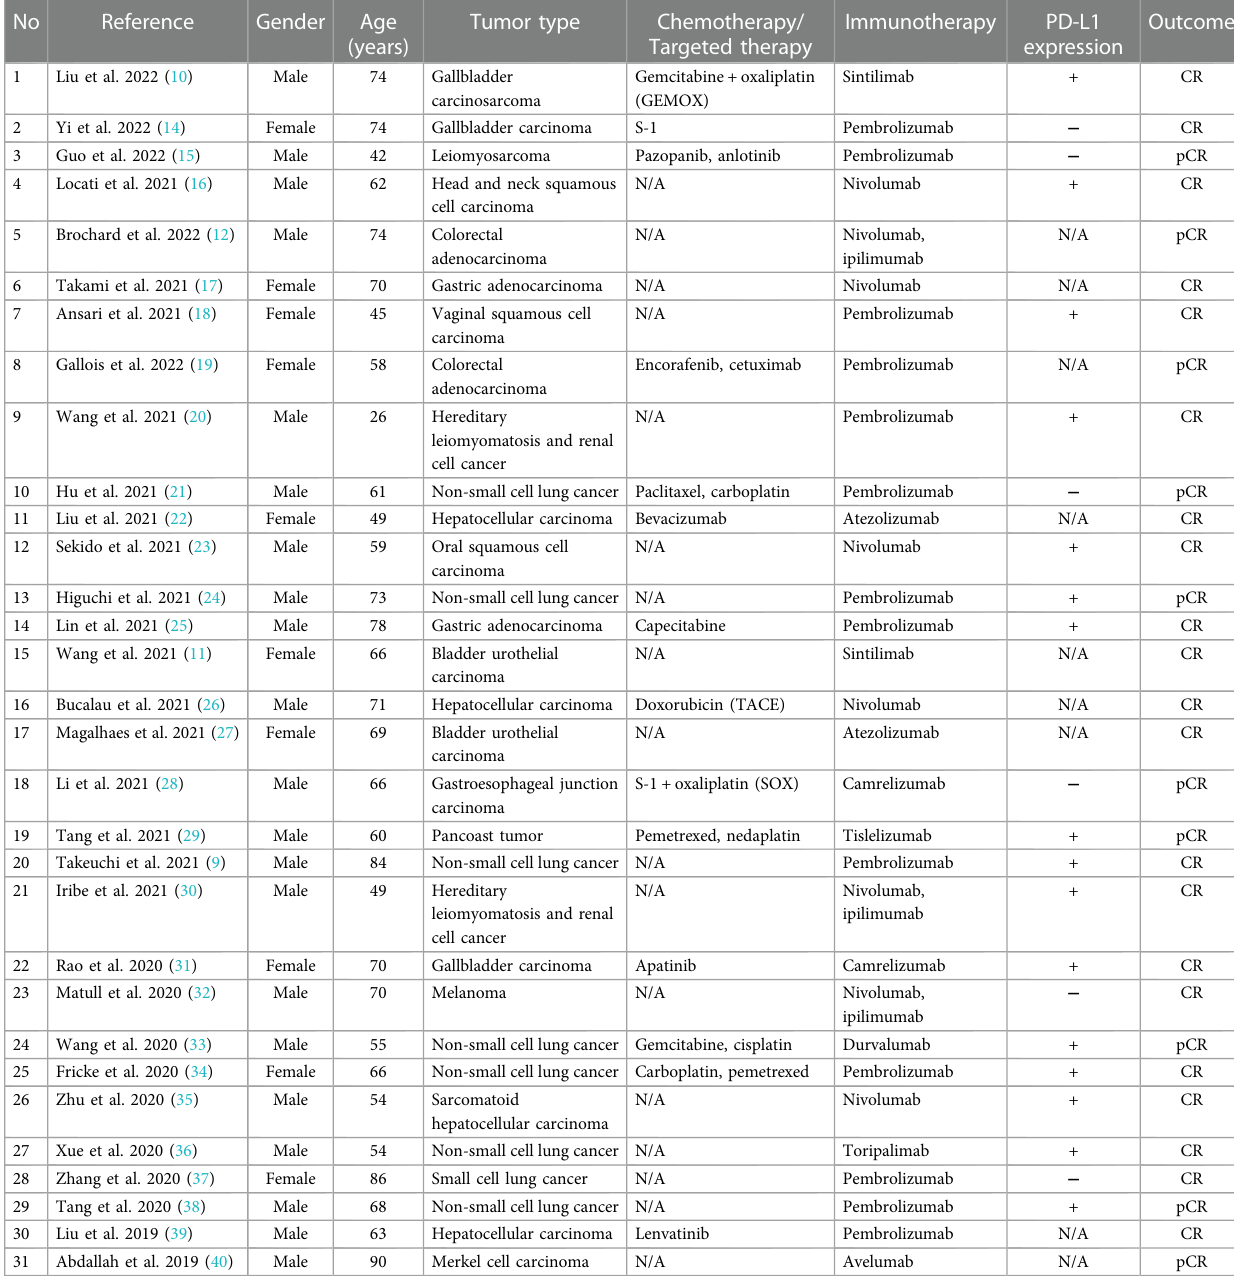
TABLE 1 The cases of complete response after immunotherapy in combination with/without chemotherapy/targeted therapy. No